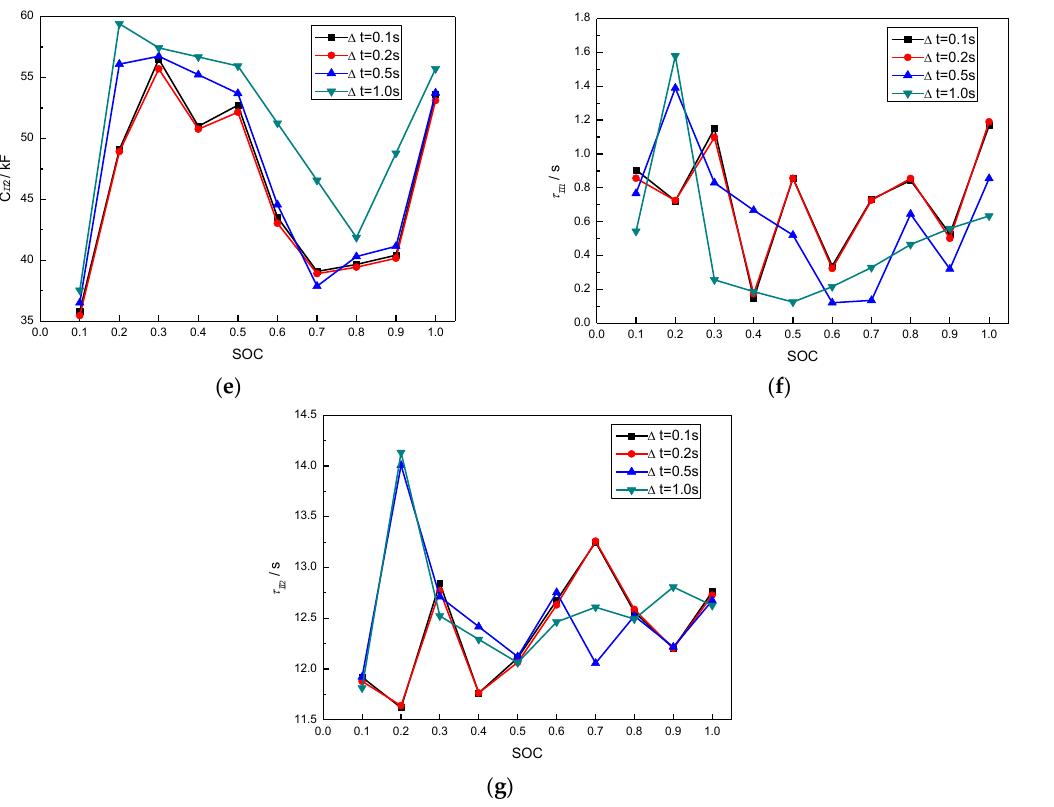
Figure 12. Change curves of parameters with SOC of 2-RC circuit model: ( a ) R II0 ; ( b ) R II1 ; ( c ) C II1 ; ( d ) R II2 ; ( e ) C II2 ; ( f ) τ II1 ; ( g ) τ II2